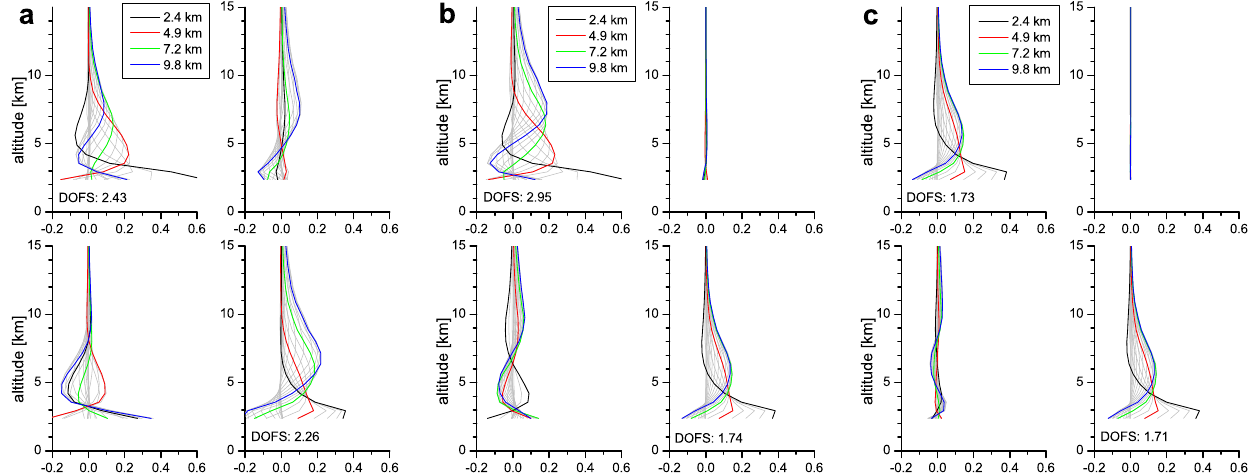
Fig. 3. Row kernels of the water vapour state corresponding to the example spectrum of Fig. 2. Panel a: in the { ln [H 2 O] , ln [HDO] } -basis; Panel b: in the { (ln [H 2 O] + ln [H 2 O]) / 2 , ln [HDO] − ln [H 2 O] } -basis; Panel c: same as panel b, but optimized for isotopologue studies (see text for more details).